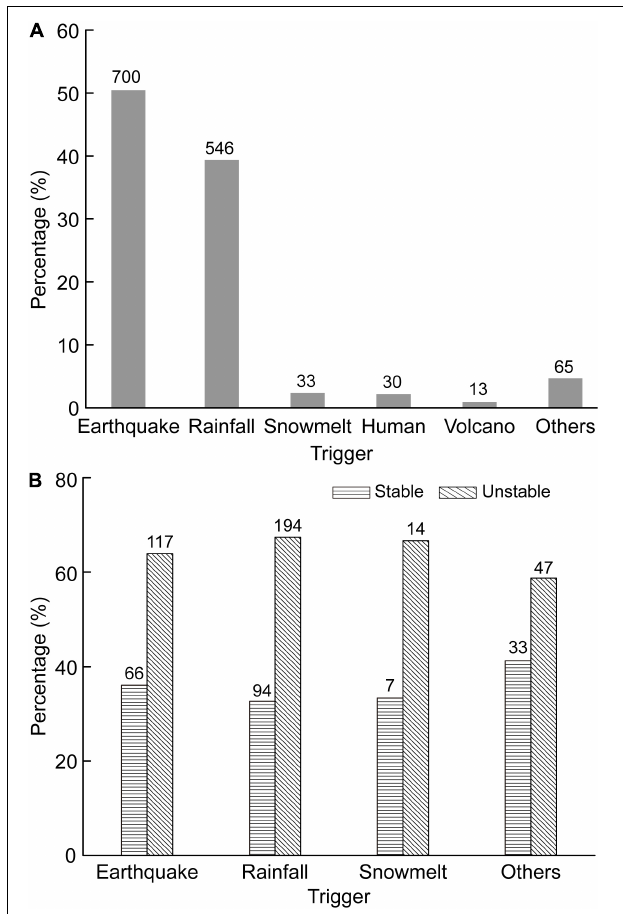
FIGURE 4 | Effects of landslide dam trigger on the stability: (A) landslide dam triggers and (B) landslide dam stability.